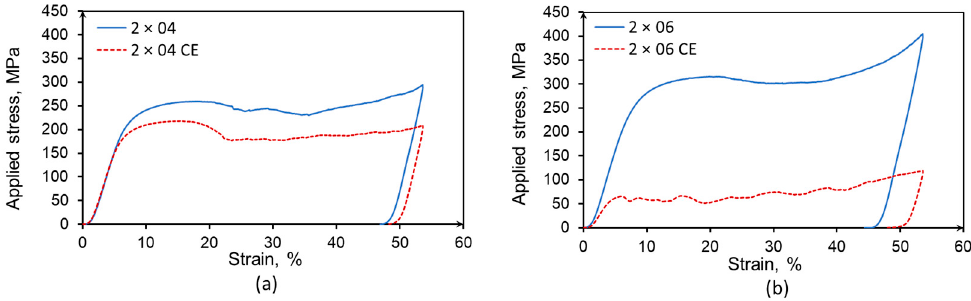
Figure 9. ( a ) WT as a function of distance to the edges; ( b ) the difference between as-build (PRS) and CE WT as a function of distance to the edges.